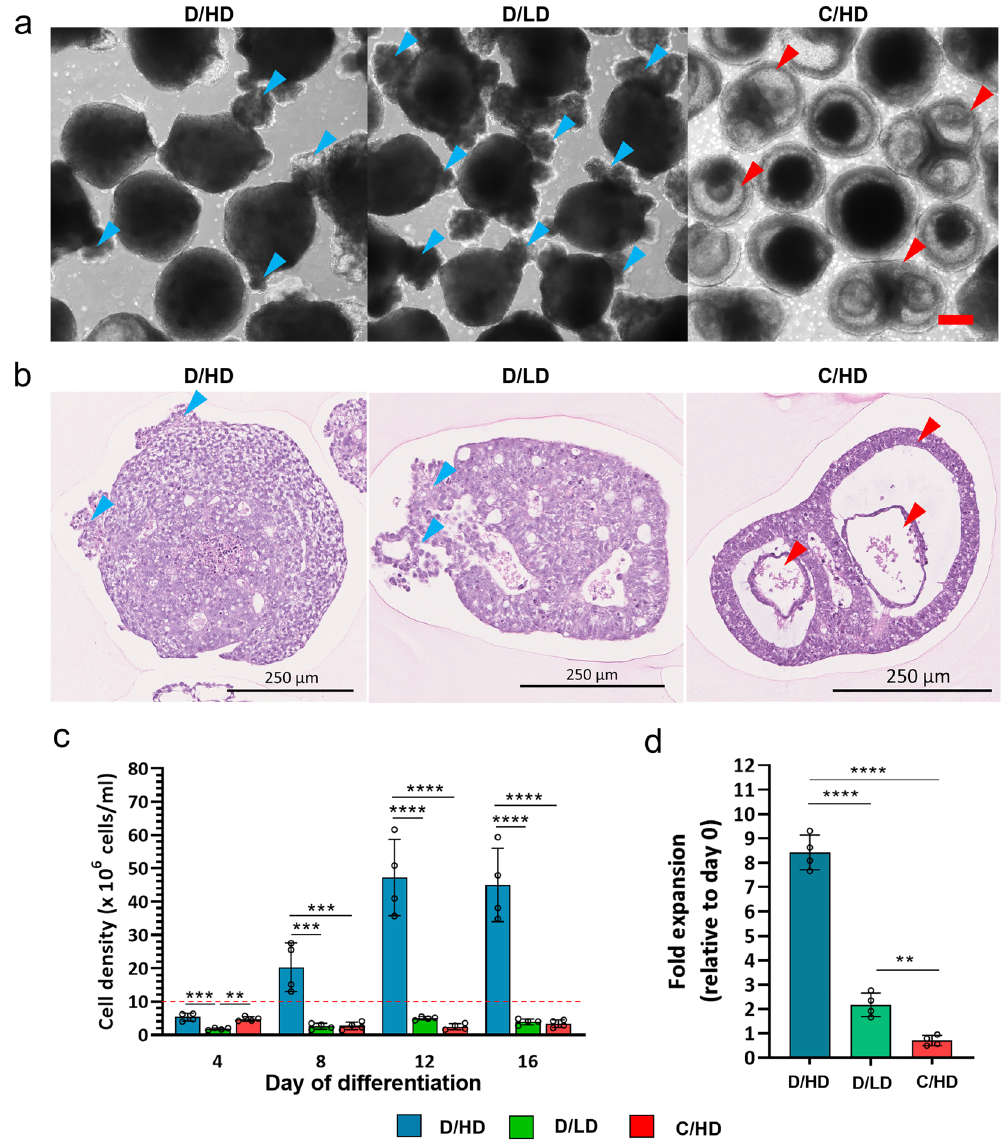
Figure 2. Morphology and growth rate of hiPSC-derived liver organoids (HLOs). ( a ) Morphological appearances of HLOs are generated from different cultural systems. The condensed cystic structure is depicted by blue arrows and cavitated cystic structure by red arrows. ( b ) The cross-sectioned histological morphology of the dense HLOs and complete cyst-like-HLOs. The condensed peripheral cystic structure showed by blue arrows and the cyst cavity showed by red arrows. ( c ) The medium conditioning in the dialysis system (D/ HD) supported the HLOs differentiation in high density with ( d ) higher proliferation rate (n = 4 biologically independent experiments). The dotted line shows the minimum criteria of high-density mammalian cell culture, referring to Griffiths et